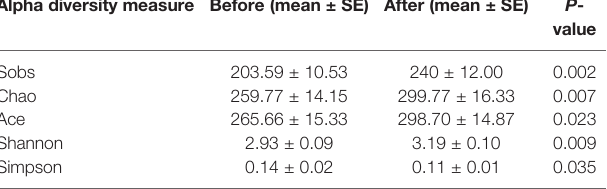
TABLE 2 | Intestinal fl ora diversity and abundance before and after 6-week combined exercise and diet intervention. Alpha diversity measure Before (mean ± SE) After (mean ± SE) P -